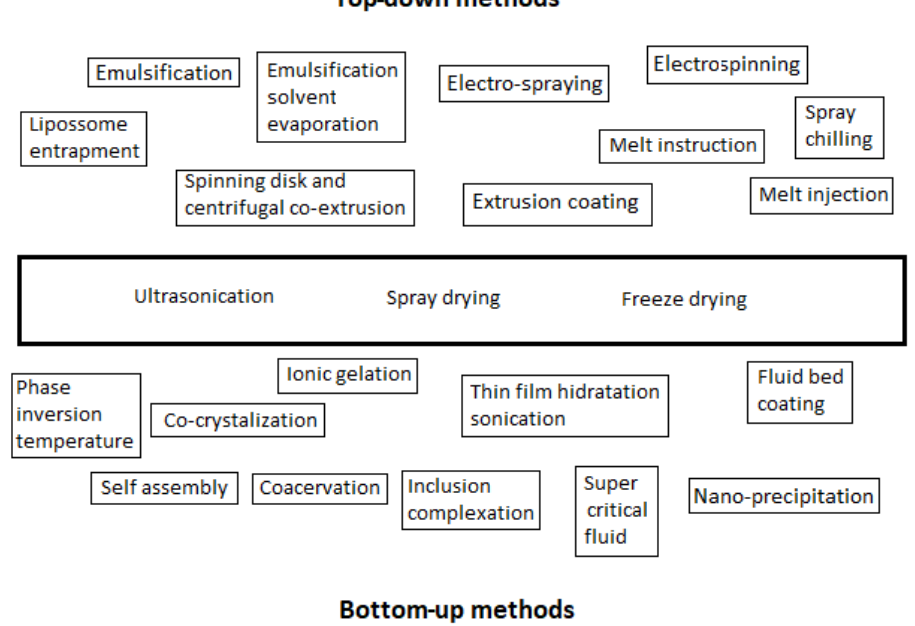
Figure 1. Techniques to produce micro- and nanocapsules, according to the top-down and bottom-up methodologies.